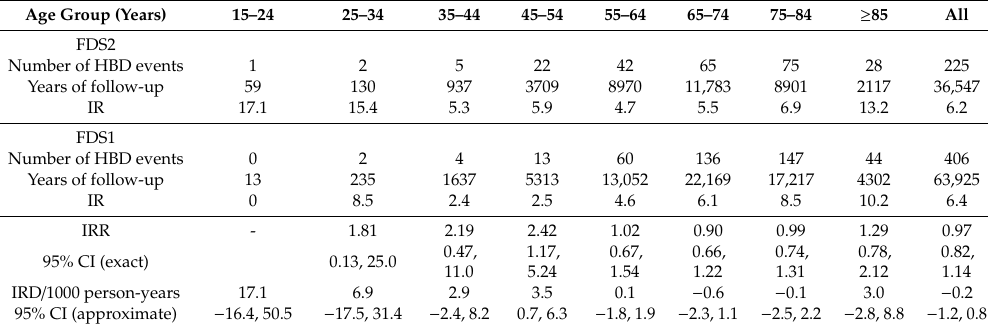
Table 6. Age-specific incidence rates (IRs) per 1000 person-years, incidence rate ratios (IRRs), and incident rate di ff erences (IRDs) for first-ever hospitalization for / with or cancer registration or death from / with hepatobiliary disease (HBD) in people without diabetes for the Fremantle Diabetes Study Phase II (FDS2) versus the Fremantle Diabetes Study Phase I